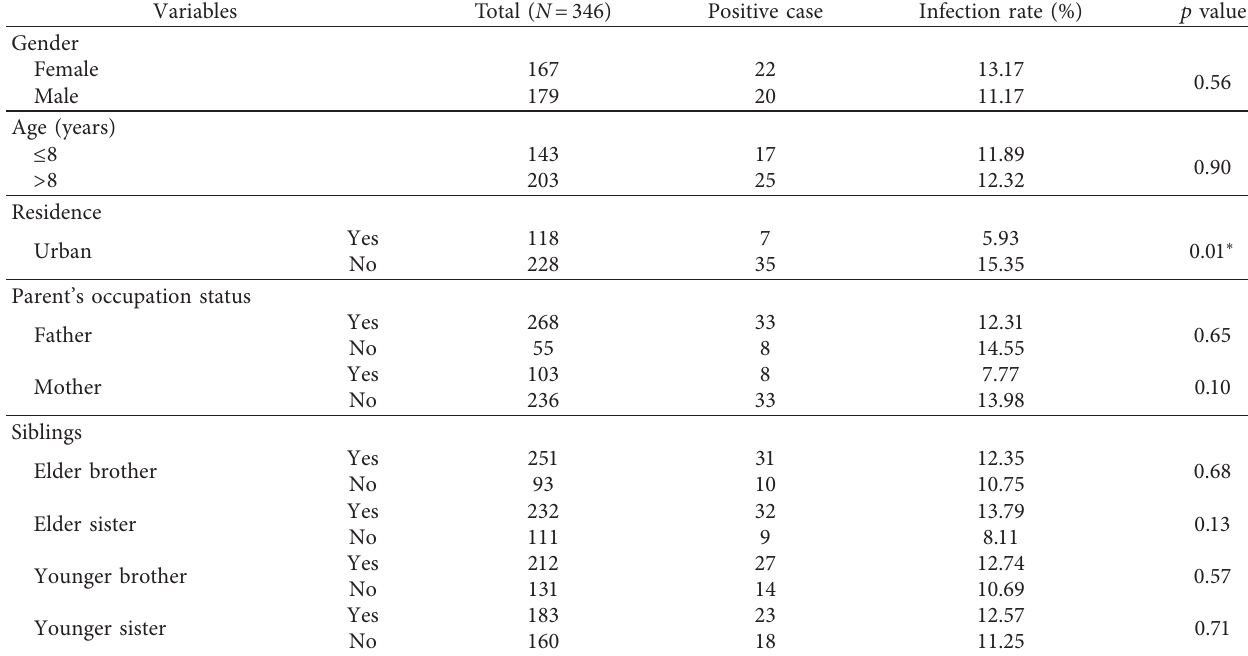
Table 1: Demographic analysis of family background of Enterobius vermicularis infection among primary schoolchildren in the Marshall Islands.